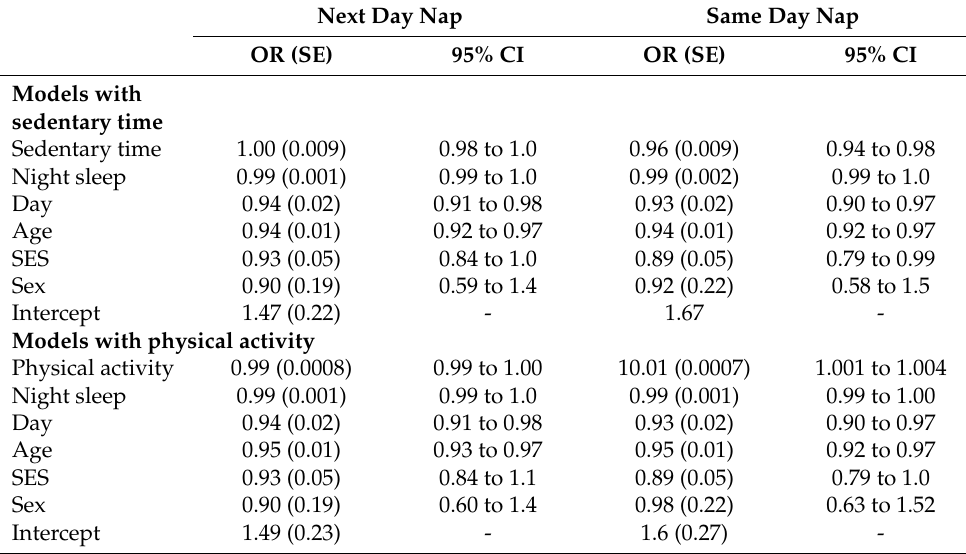
Table 2. Multilevel logistic regression model results for likelihood of